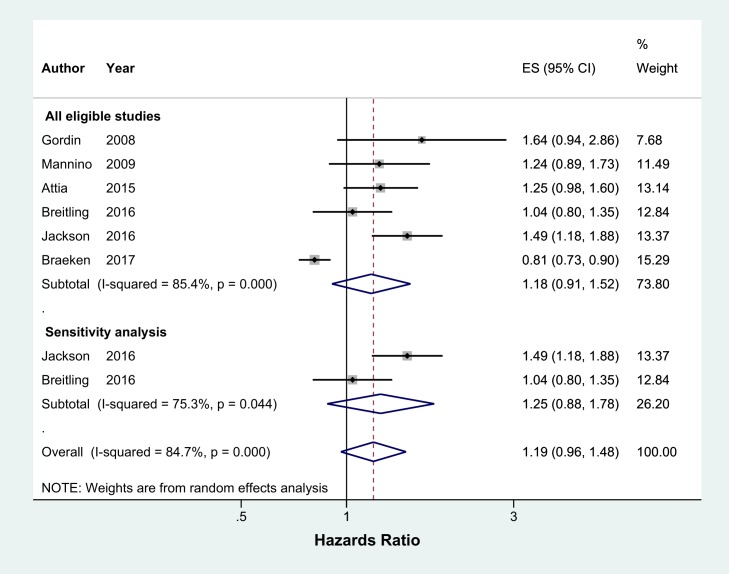
Meta-analysis of incidence of community acquired pneumonia in ex-smokers relative to never smokers (Hazards Ratio).Grey box = effect estimates from single studies. Diamond = pooled result with confidence interval. Vertical line at ‘1’ on the x-axis is the line of no effect. Weight (in %) = influence an individual study had on the pooled result.